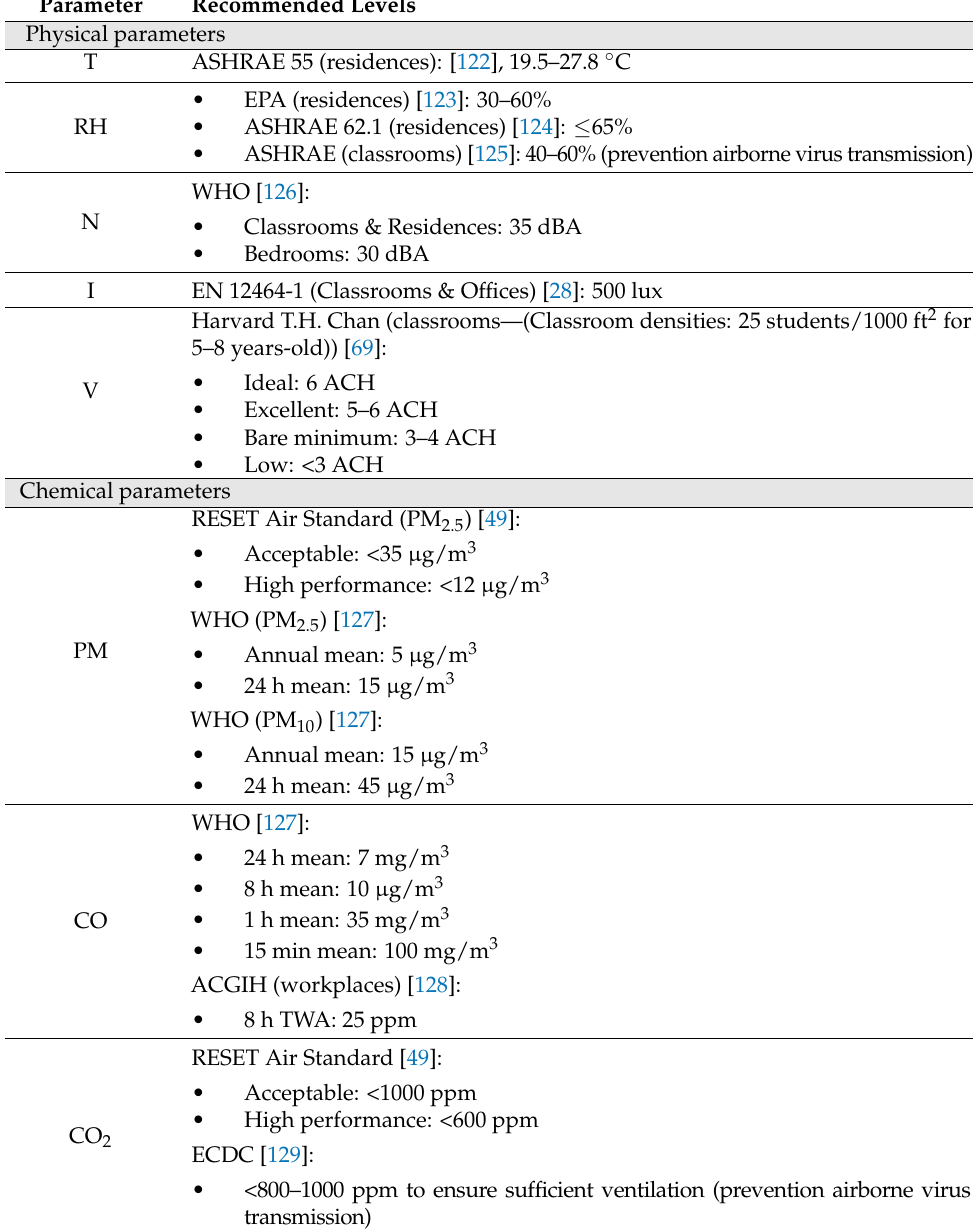
Table A1. Recommended